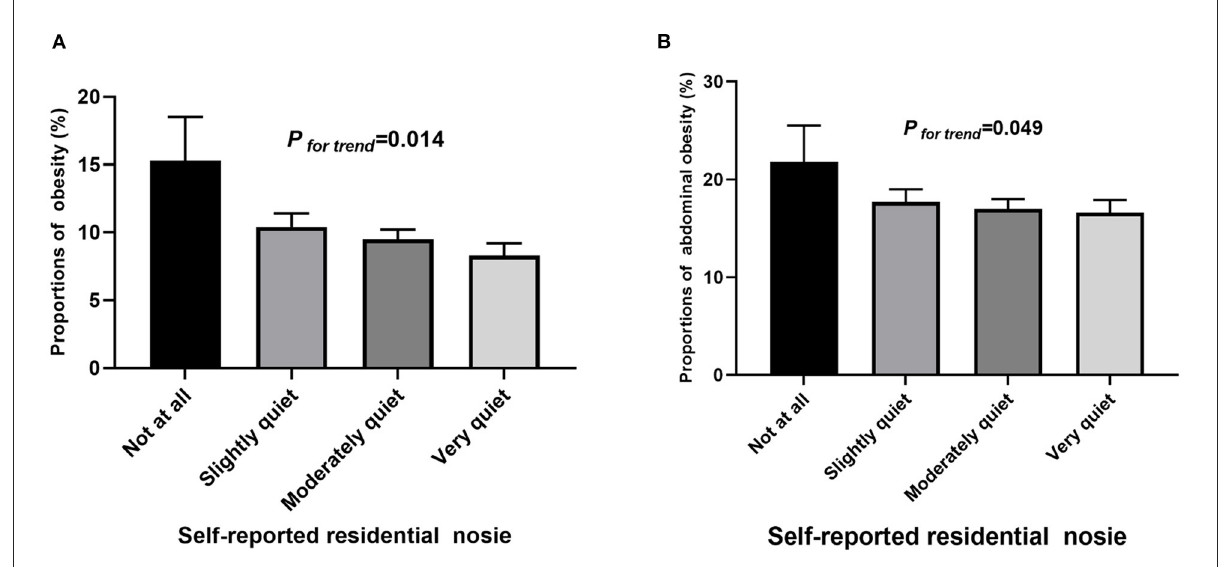
FIGURE1 Proportions of (A) obesity and (B) abdominal obesity by self-reported residential noise exposure.